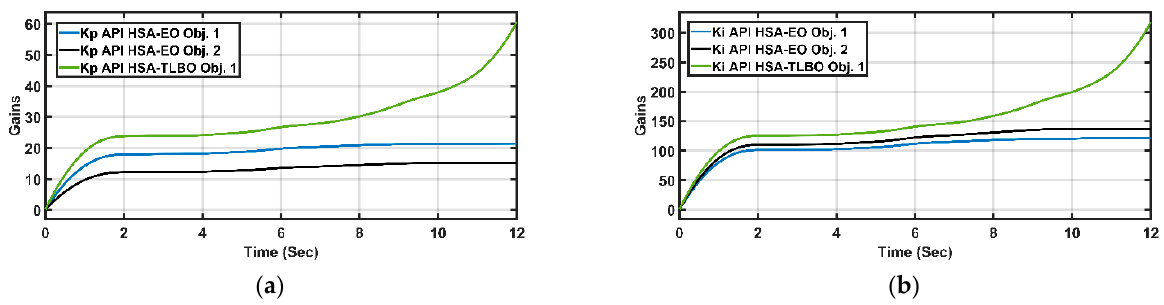
Figure 17. ( a ) (cid:1837) (cid:3043) adaptive PI gain of normal second case. ( b ) (cid:1837) (cid:3036) adaptive PI gain of normal second case.